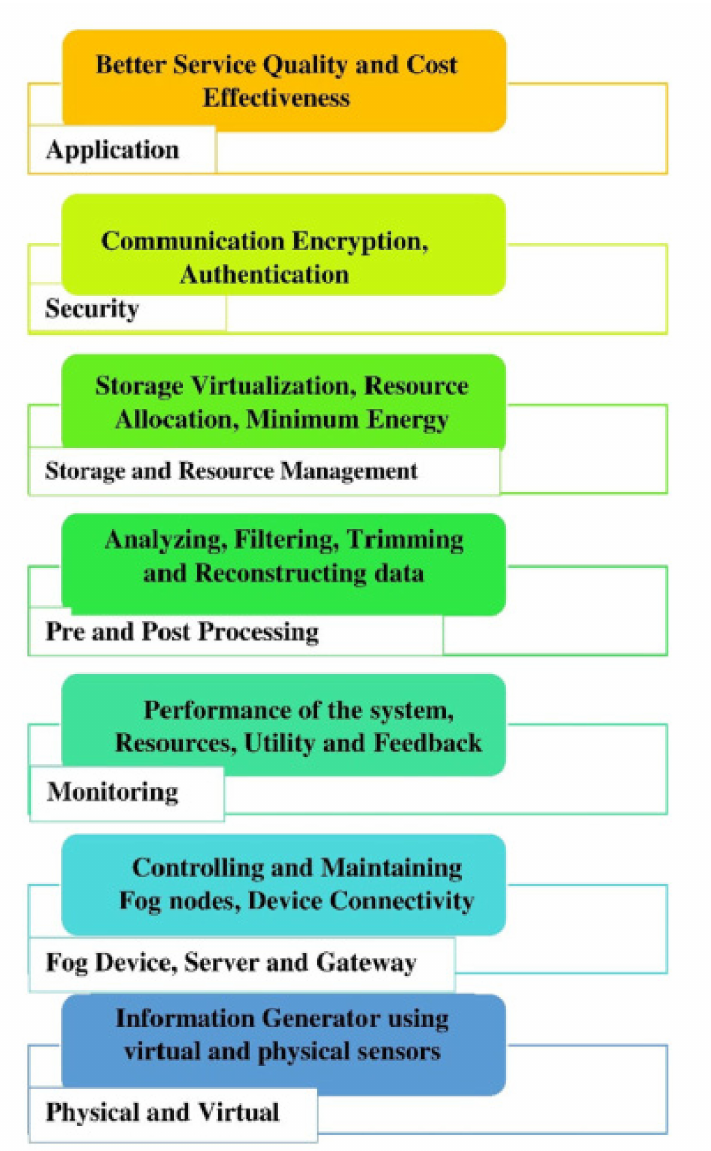
Figure 5. Architectural Solution for stated issues in